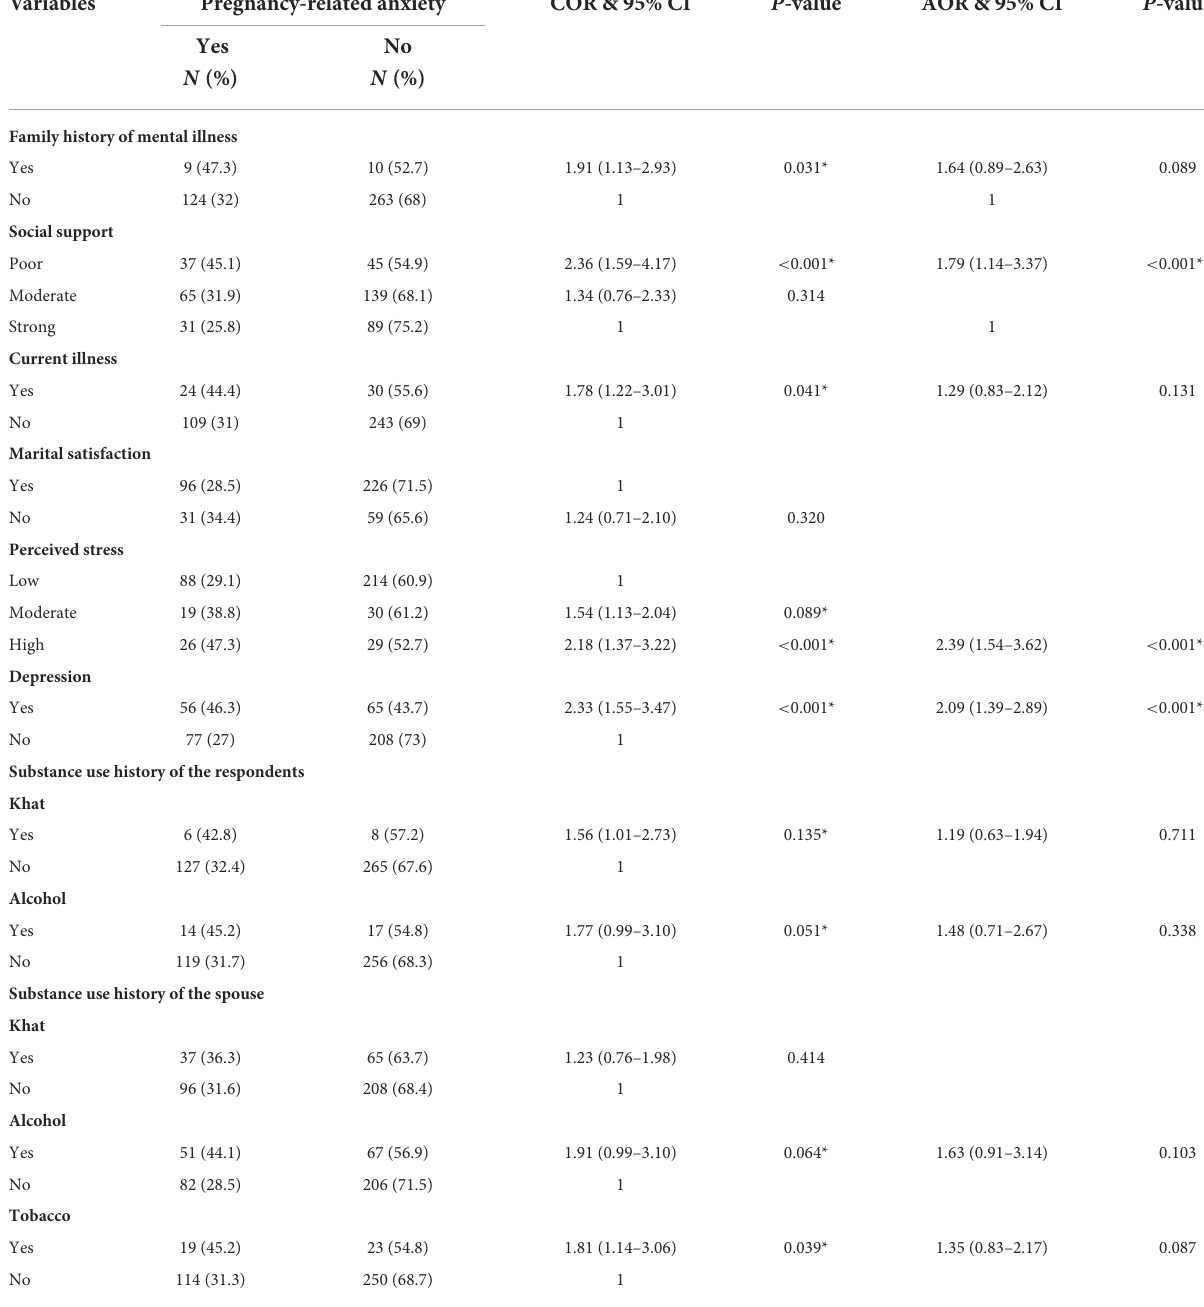
TABLE 5 Bivariate and Multivariate binary logistic regression analysis showing the association between PRA and psychosocial, substance use, and health-related variables among pregnant women attending ANC follow-up Bedelle general hospital and Metu Karl comprehensive specialized hospital, 2021 ( N =